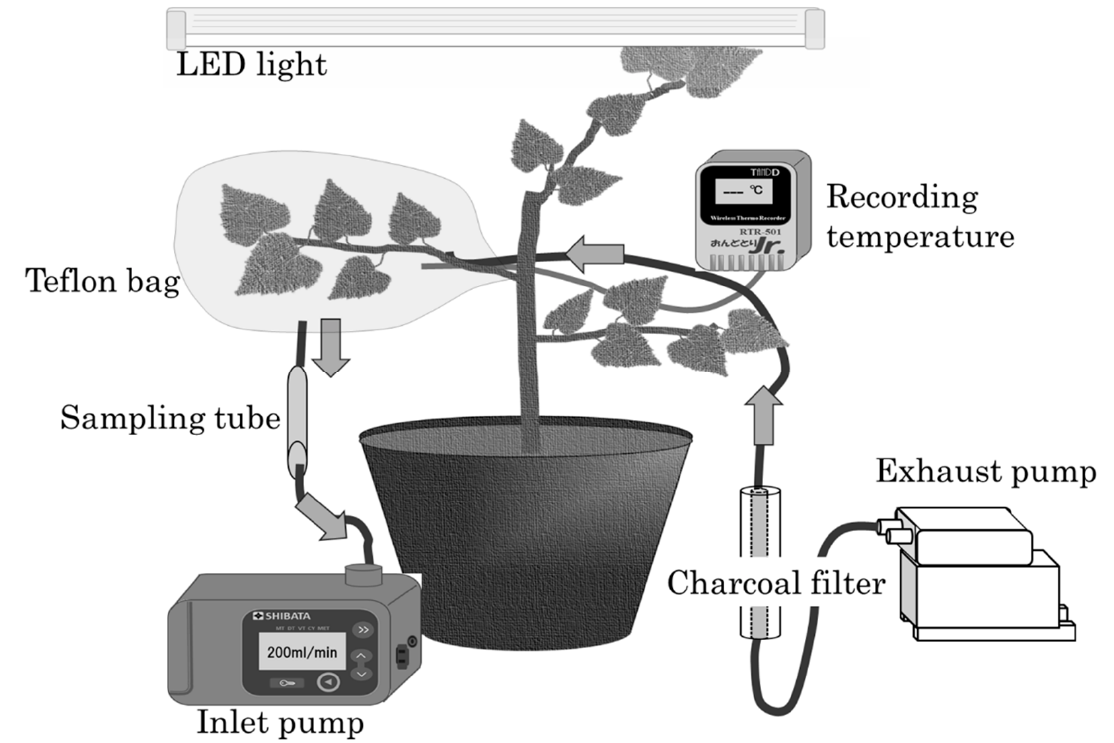
Figure 2. Branch chamber method for sampling of volatiles emitted from leaves of white birch. Each arrow in this figure means the aerial direction.